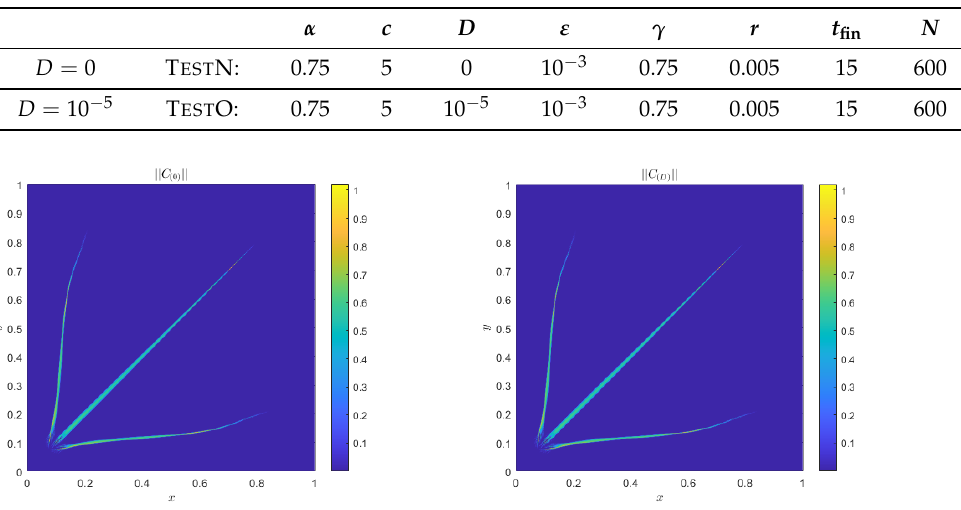
Figure 5. Comparison between T EST N and T EST O, with initial condition defined in Equation (29). The main difference is that on the left, we have D = 0, while on the right, we have D = 10 − 5